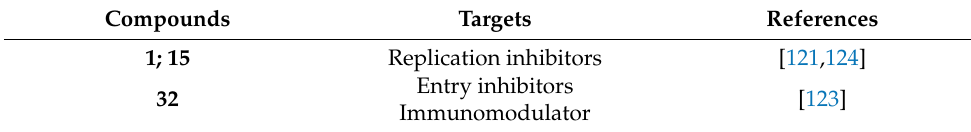
Table 11. Summary of anti-PRRSV triterpenoids and their targets and activities.